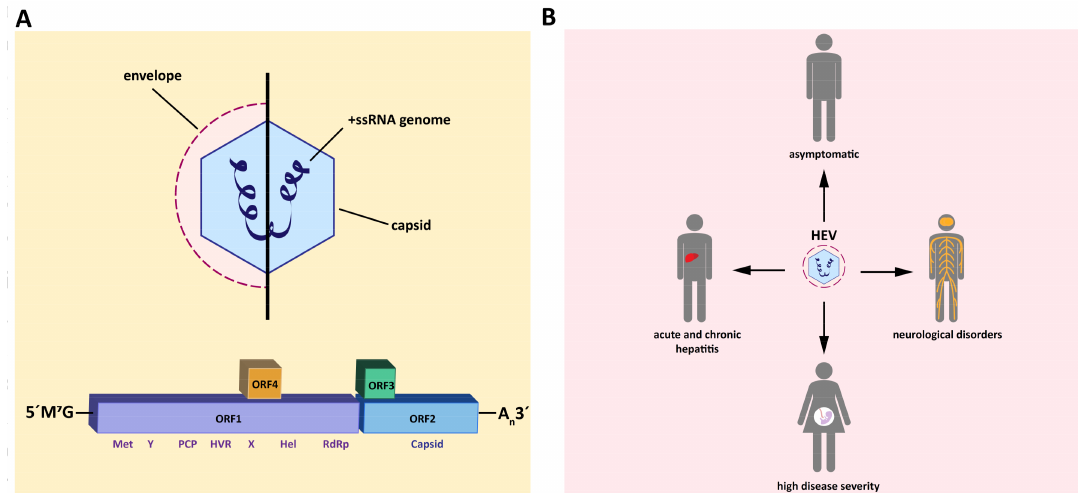
Figure 1. Schematic representation of hepatitis E virus (HEV) particle and the major clinical manifestations. ( A ) HEV particle and genomic organization. The HEV genome is composed of a single-stranded RNA genome of ~7.2 kb and is encapsulated in an icosahedral capsid. HEV virions can occur in both a non-enveloped and in an enveloped form. The viral RNA, which is capped with 7-methylguanosine (7mG) at the 5´noncoding region and polyadenylated at the 3 (cid:48) noncoding region, comprises three open reading frames (ORF). Furthermore, GT1 is believed to contain an additional ORF (ORF4). ORF1 encodes the replicase proteins, including a methyltransferase (MT), cysteine protease (Pro), helicase (Hel), and RNA polymerase (Pol), as well as three regions without a reported enzymatic function (Y, hypervariable region (HVR), and X). ORF2 encodes the capsid protein, whereas ORF3 encodes a viroporin. ( B ) Major clinical manifestations. The majority of HEV infections are asymptomatic. GT3 and GT4 infections can become chronic in immunosuppressed individuals, with high risk for developing severe complications, such as liver cirrhosis. HEV has also been reported to cause a